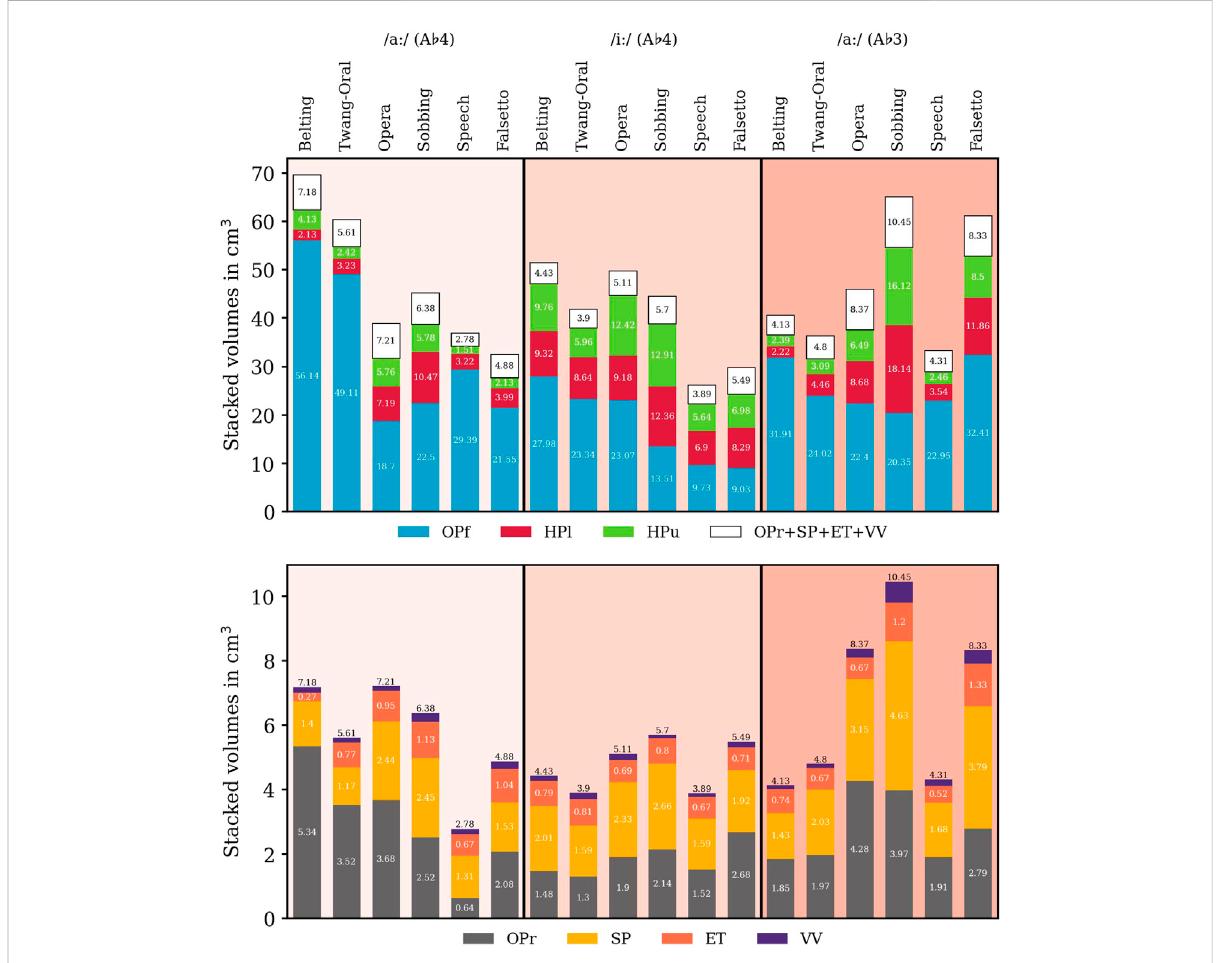
FIGURE 4 Volumes of sub-volumes for all voice qualities, vowels, and pitch values in cm 3 . Consistently to Figure 2, the oropharynx front (OPf) and the oropharynx rear (OPR) are symbolized by blue and gray color, and the upper hypopharynx (HPu) and the lower hypopharynx (HPl) are highlighted green and red, respectively. The epilarynx tube (ET), Sinus piriformis (SP), and ventricular volume (VV) are highlighted in orange, yellow, and purple, respectively. For clarity reasons, the anatomical order is not